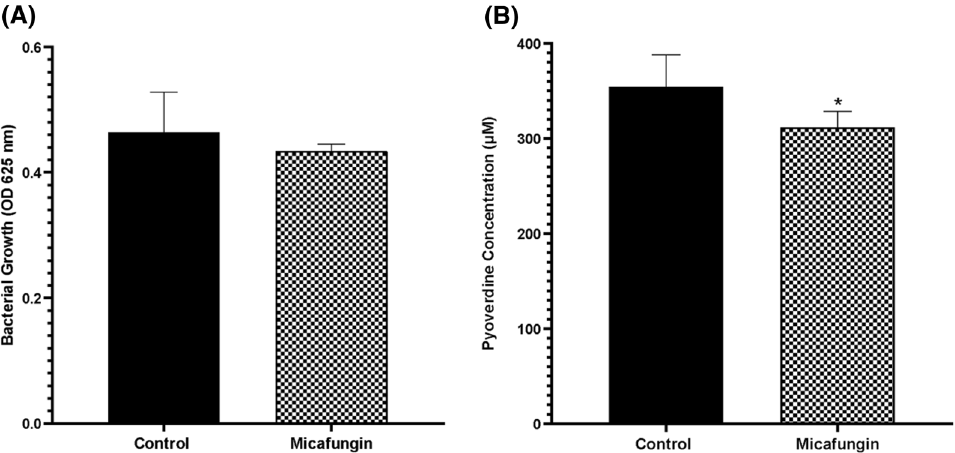
Fig. 1 The effect of micafungin 100 µg/mL along with control [without any treatment (n production of P. aeruginosa . Data was analysed by independent Student’s t ‑test. Significant in comparison to control is expressed as * P ‑value